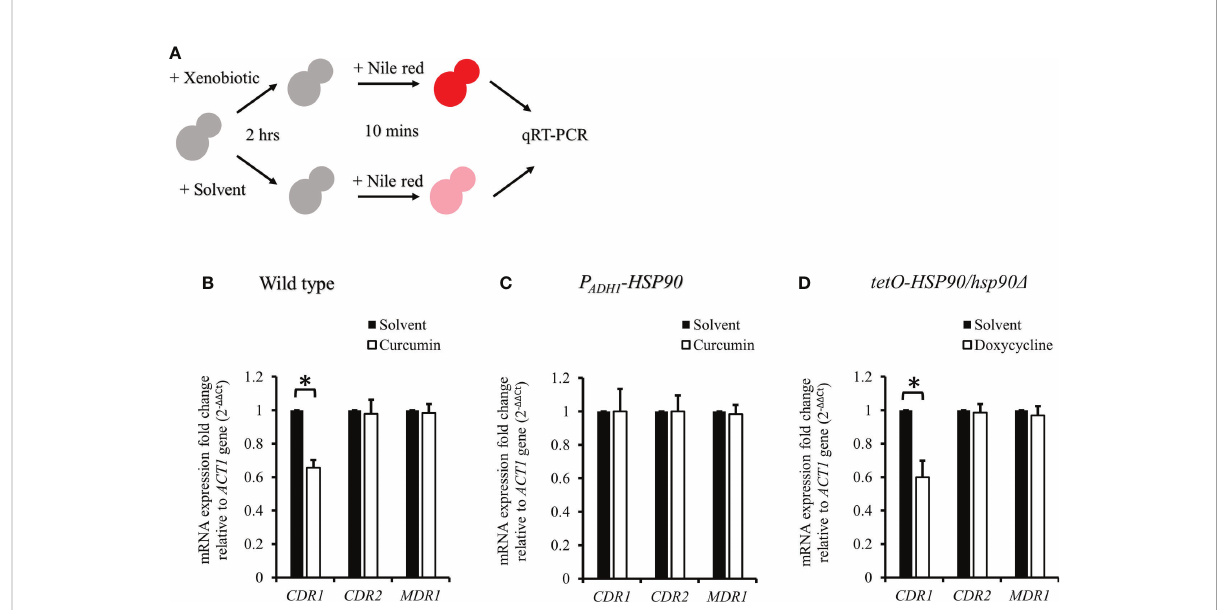
FIGURE 8 CDR1 , CDR2 , and MDR1 gene expressions in C. albicans after treatment with xenobiotics for 2 h and Nile red for 10 min. (A) Diagram showing the qRT-PCR experiment. (B – D) mRNA amounts of CDR1 , CDR2 , and MDR1 were determined by qRT-PCR in wildtype, P ADH1 -HSP90 , and tetO- HSP90/hsp90 D strains. * indicates a statistically signi fi cant difference (p<0.05) compared to the respective control